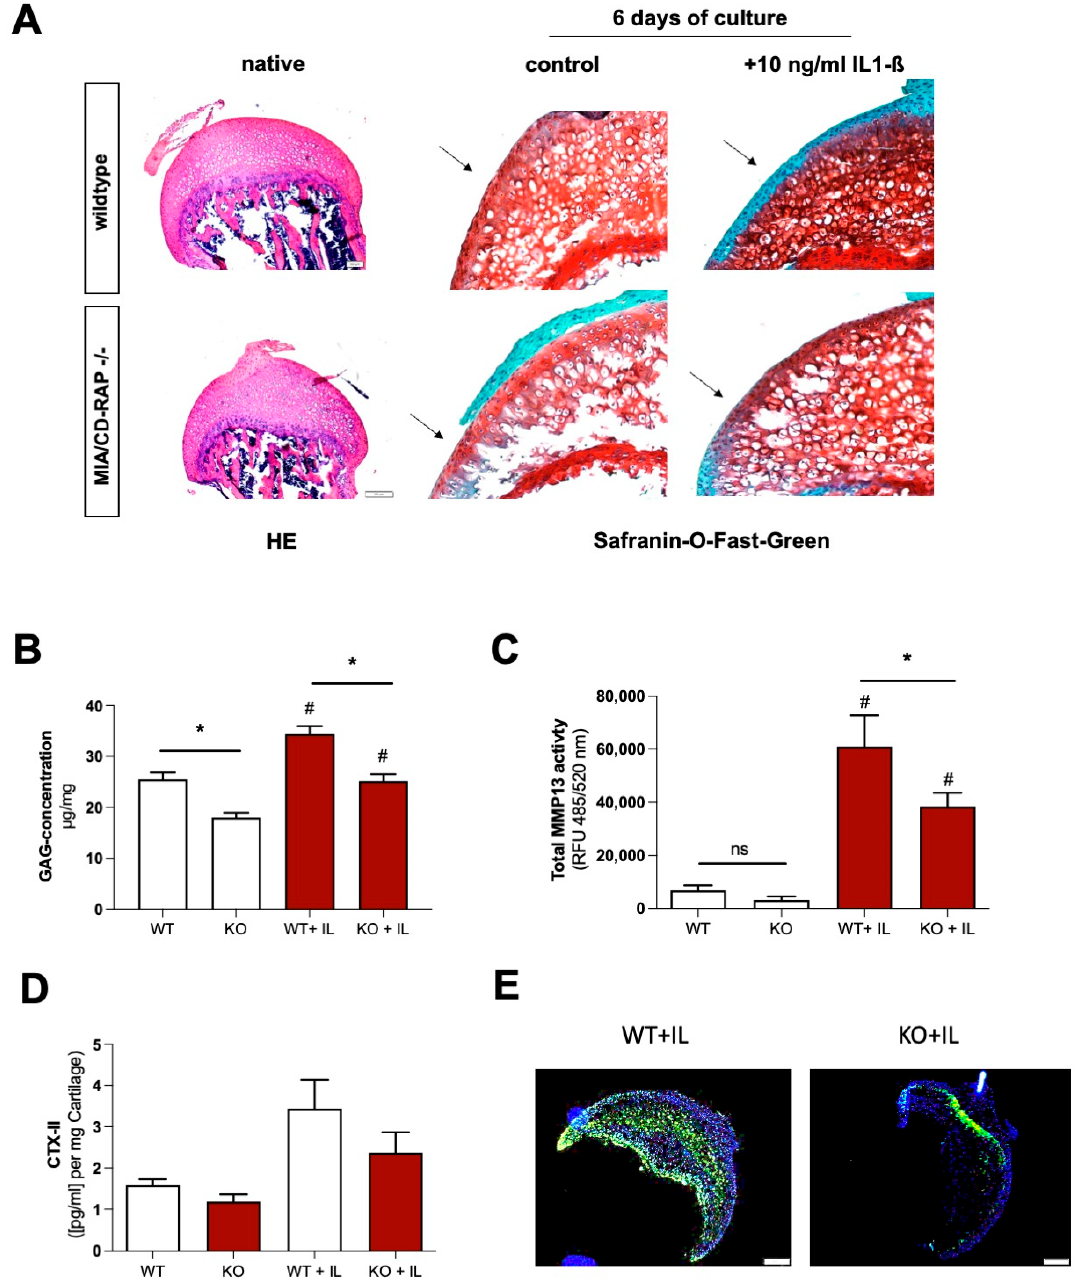
Figure 4. ( A ) Hematoxylin and eosin (HE) staining of wildtype and knockout cartilage. Safranin- O–fast green staining of femoral head cartilage explants after culturing for 4 days with or without 10 ng/mL IL-1 β . ( B ) Dimethylmethylene Blue assay (DMMB) to quantify the sulfated GAG release into the medium supernatant ( n = 10 each genotype). ( C ) Total MMP13 activity in medium su- pernatant after 4 days of IL-1 β . n = 10; one-way ANOVA followed by Tukey’s HSD post hoc test; (*: p < 0.05.; #: significant ( p < 0.05) to respective untreated cells) ( D ) ELISA for quantification of c-telopeptide fragments of type II collagen (CTX-II) in medium supernatant n = 5; one-way ANOVA followed by Tukey’s HSD post hoc test; *: p < 0.05. ( E ) Elevated number of TUNEL-positive cells of in vitro cultured wildtype articular cartilage explants after stimulation with IL-1 β . Magnifica- tion: 10 × ; one-way NOVA followed by Tukey’s HSD post hoc test (*: p < 0.05). Bars are shown as mean ±